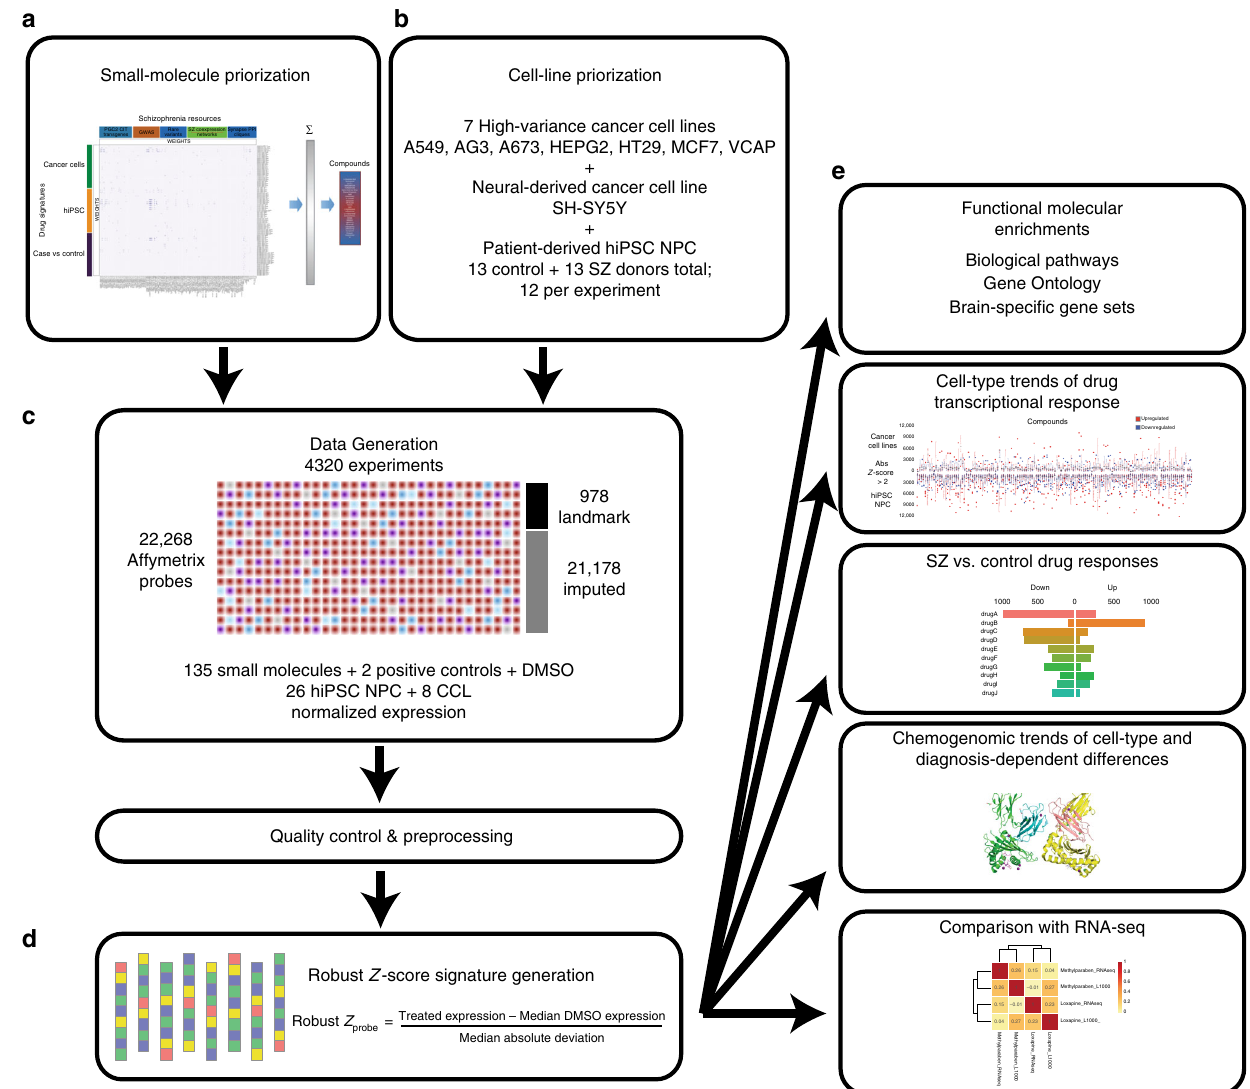
Fig. 1 Summary schematic of experimental and analytic pipeline. a One hundred and thirty- fi ve drugs were prioritized for screening based on connectivity with diverse aspects of SZ-related biology. b Cells used for screening comprised seven CCLs (A549, AGS, A673, HEPG2, HT29, MCF7, and VCAP) that were prioritized using LINCs datasets, one additional neural CCL (SH-SY5Y) and hiPSC NPCs from 13 SZ and 13 control individuals (12 each per drug). c Data were generated using the L1000 platform to yield 6650 drug-perturbation transcriptomic pro fi les (135 drugs tested across 26 hiPSC NPCs and 8 CCLs). After data quality control, normalized expression was converted to d robust Z -scores based on comparison with isogenic DMSO-treated experiments, and used as inputs for e functional molecular enrichments, cell-type-speci fi c (hiPSC NPCs and CCLs) trends, diagnosis-dependent (SZ and control) responses, and chemogenomics analyses. Global transcriptomic responses of two drugs were tested across hiPSC NPCs from three SZ and three control individuals by RNA-seq, as part of a validation of the L1000